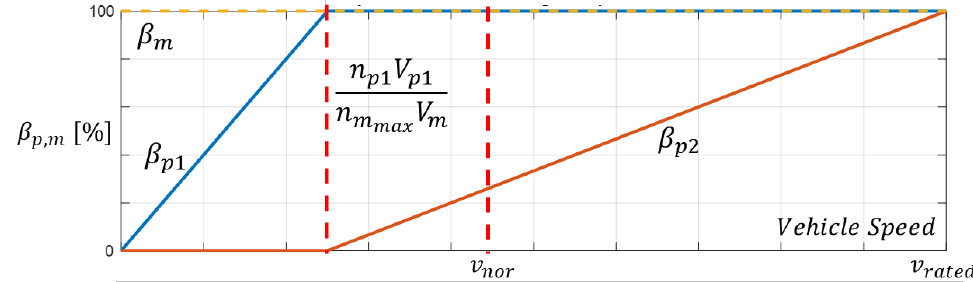
Figure 10. Pump and Motor Control for Solution A and B — High Torque Mode.